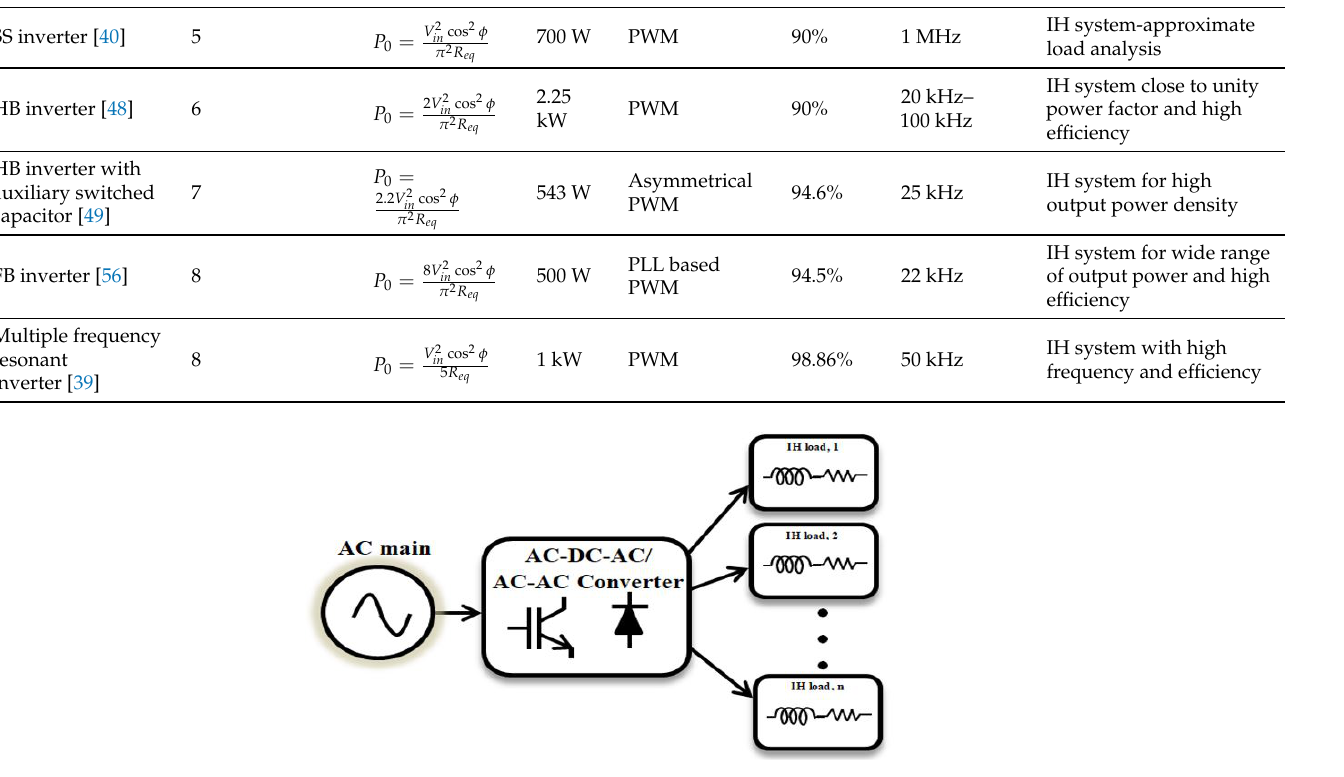
Figure 6. Multi-coil-fed topologies. Table 3. Summary of various parameters in multi-coil IH